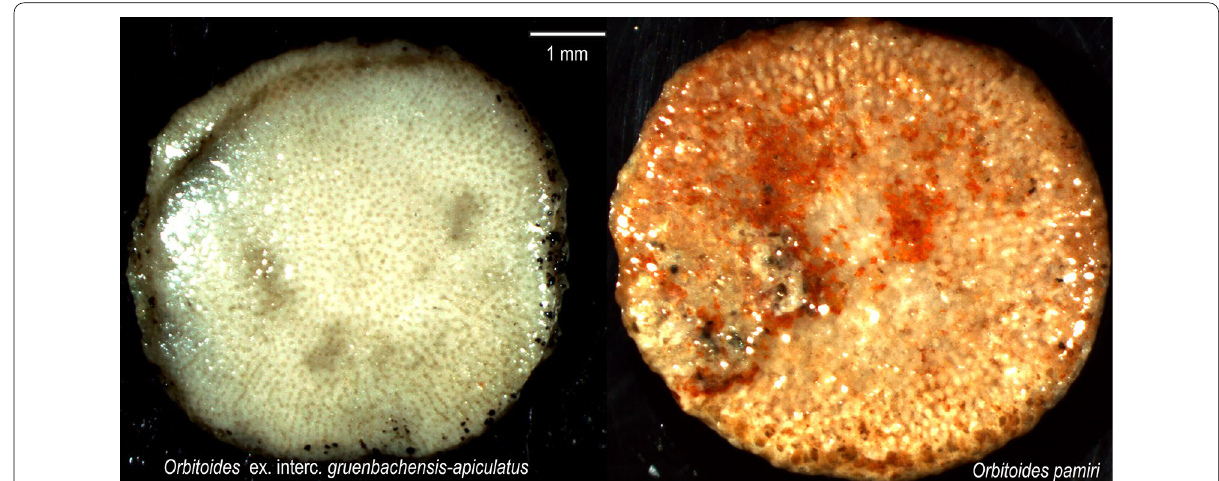
Fig. 10 External views of O. ex. interc. gruenbachensis Papp– apiculatus Schlumberger and O. pamiri from the Taraklı Formation